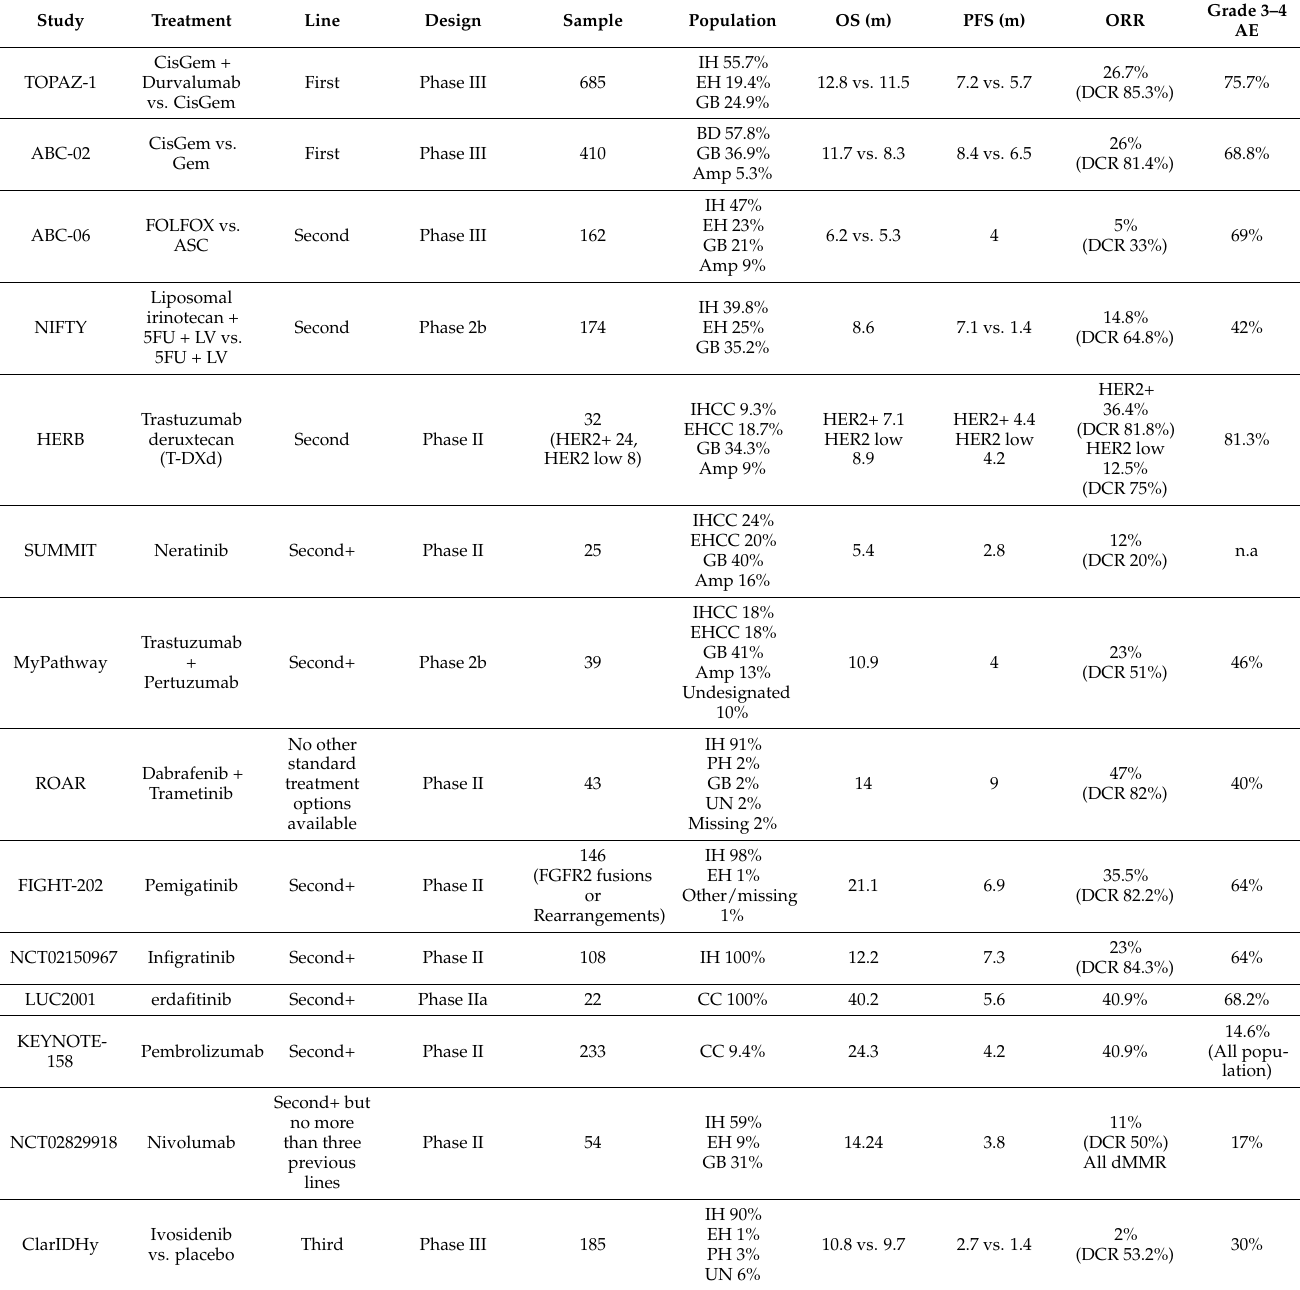
Fibroblast growth factor receptors (FGFRs) are a family of four transmembrane re- ceptors with intracellular tyrosine kinase domains (FGFR5 acts as a co-receptor of FGFR1, lacking an intracellular domain receptor), mediated by growth factors of fibroblasts